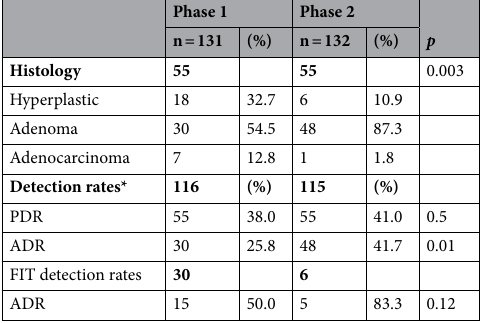
Table 4. Histology and adenoma detection rate. *After exclusion of patients with IBD and emergency situations (n = 15 in phase 1 and n = 17 in phase 2). PDR: Polyp detection rate, ADR: adenoma detection rate. Significant values are in